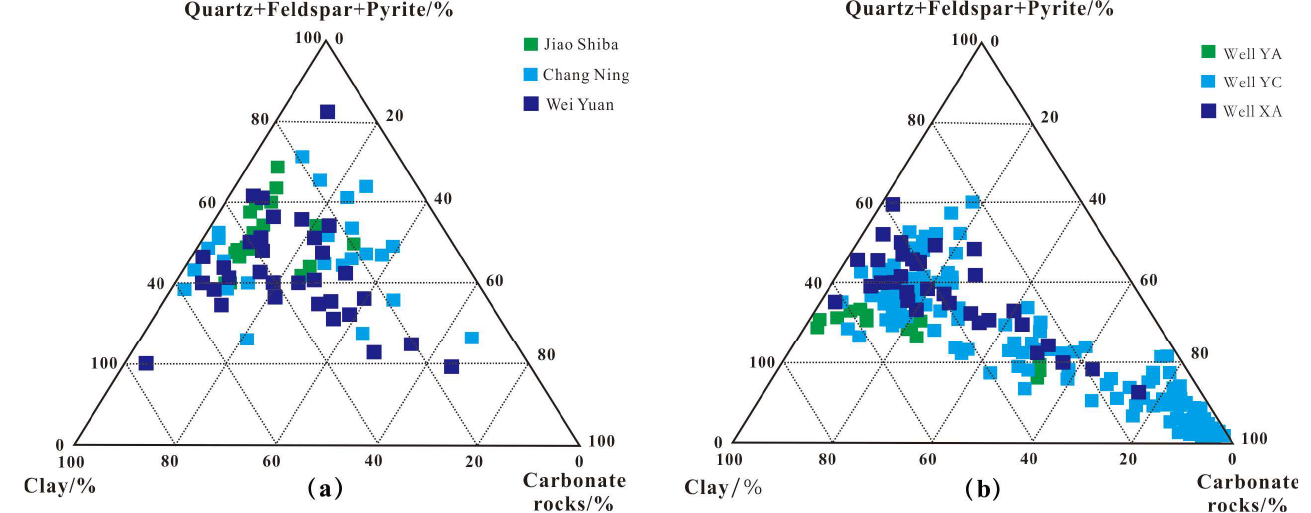
Figure 5. Mineral composition characteristics of the whole rock. (a) The ECS element logging data of XA well 3600-3870m. (b) The whole-rock mineral X-ray diffraction analysis of XA well 3714 - 3802m.